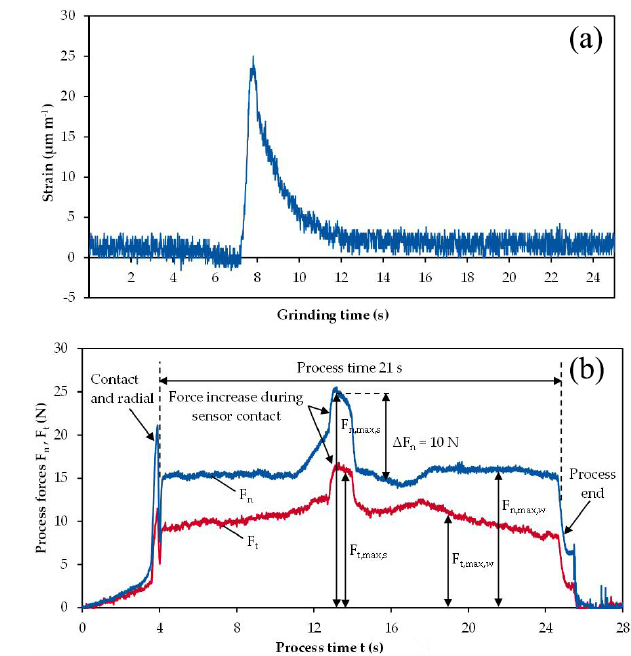
Figure 12. (a) Plot showing the measured process forces and the maximum measured strain at every grinding step during the first experimental series. (b) Plot showing the measured process forces and the maximum measured strain at every grinding step during the second experimental